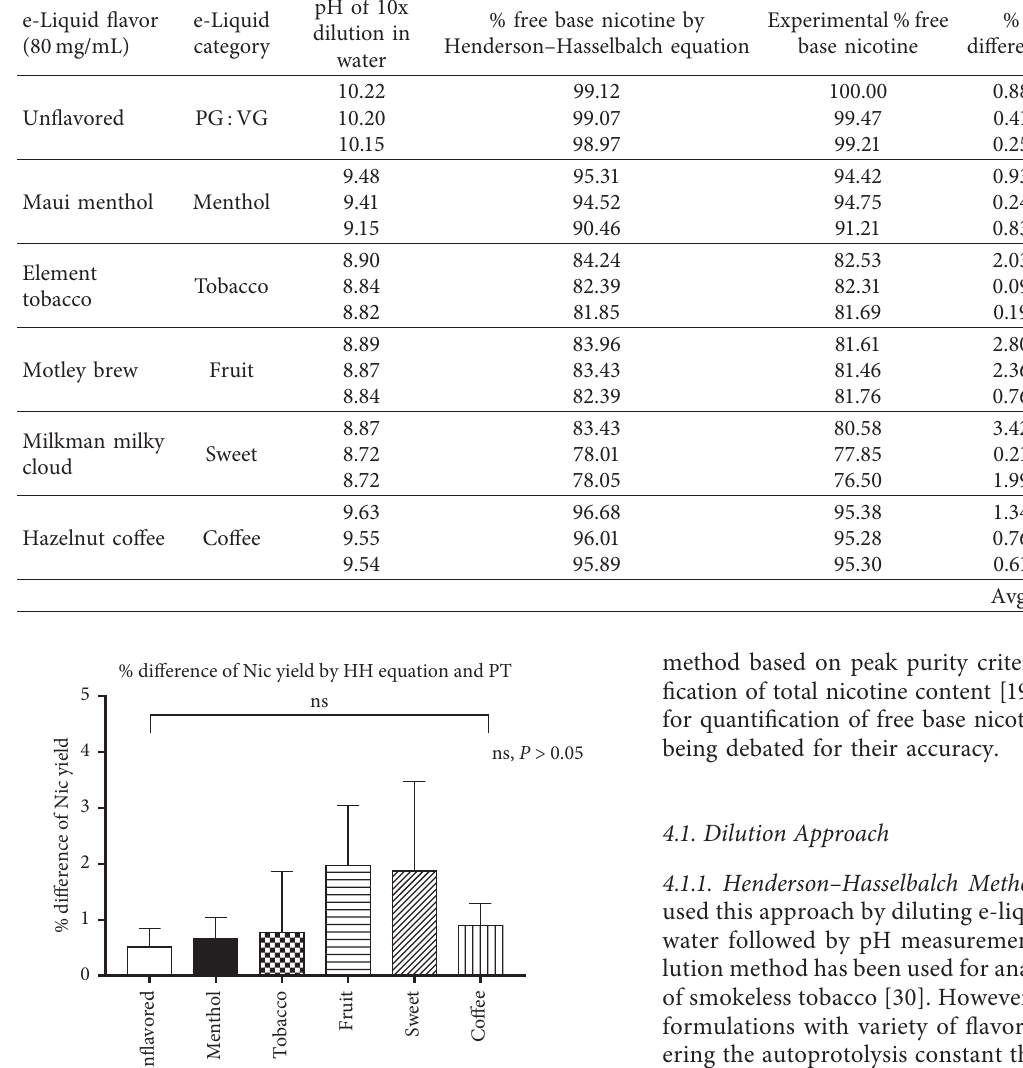
Table 1: Determination of free base nicotine in e-liquids by potentiometric titration (Henderson–Hasselbalch method). e-Liquid flavor